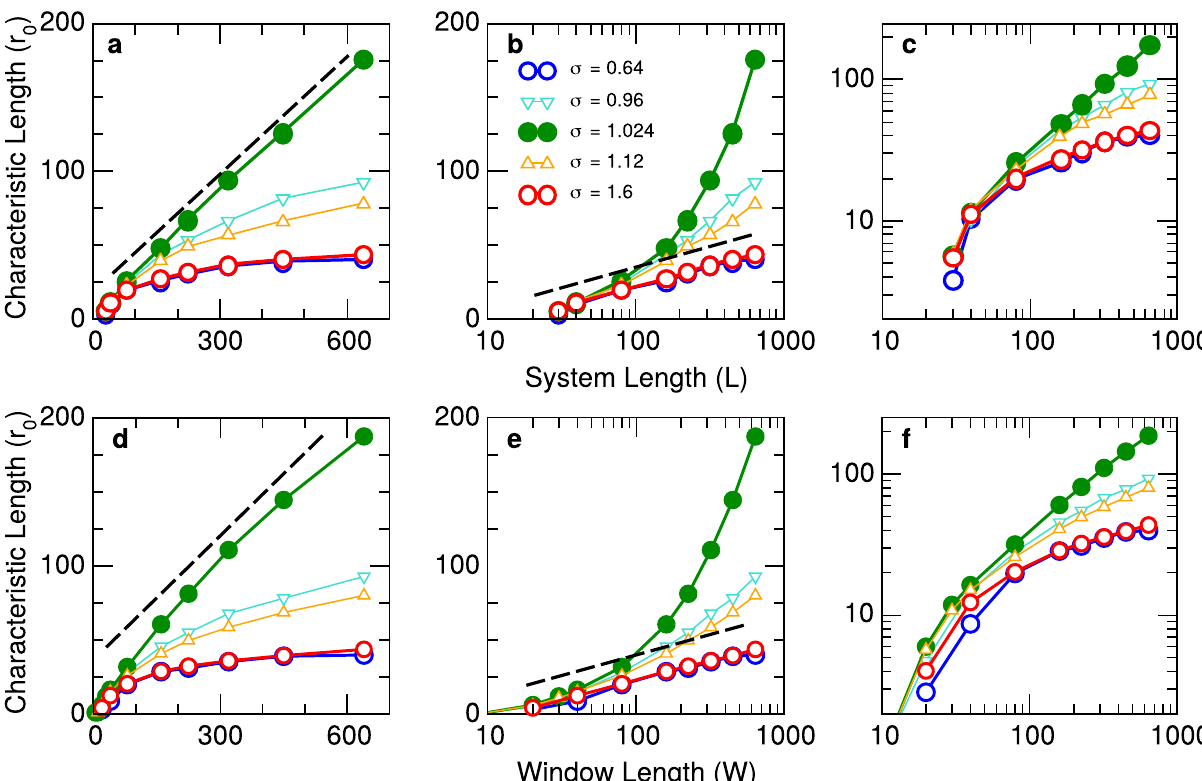
Figure 2. Characteristic Length r 0 of the neuronal network model. The zero crossings of the CCF shown in Fig. 1 are plotted in linear–linear (left), log–linear (middle) and log–log (right) axis. Top three panels correspond to different system size L and bottom three panels to different box length W . Different symbols correspond to the values of the control parameter σ denoted in the legends. Dashed lines are visual aids to emphasize the predicted logarithmic behavior for both sub-critical and super-critical regimes (open circles) and the linear dependence expected for the critical regime (filled circles). Open triangles are used to denote results obtained for intermediate values of σ . In all cases, error bars are omitted, since error estimates are smaller than symbol